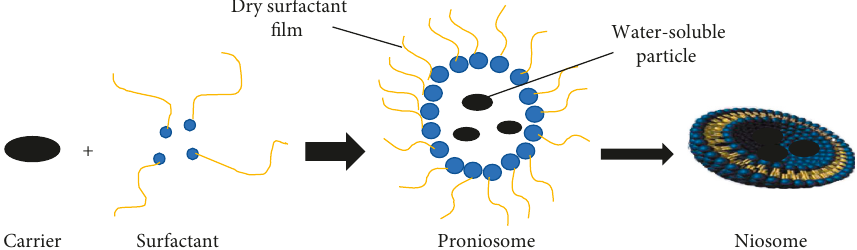
Figure 6: Schematic typical vesicle size of